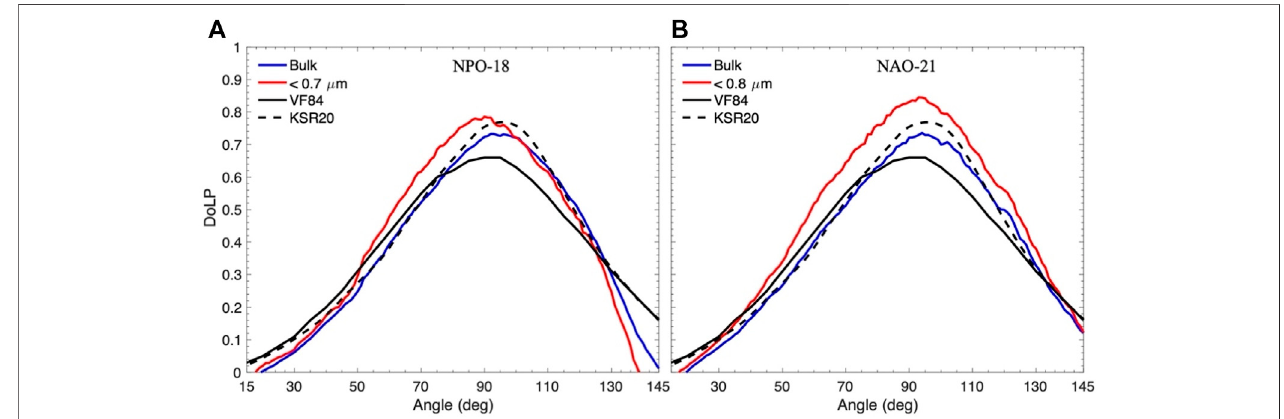
FIGURE7| Medianvaluesofdegreeoflinearpolarization(DoLP)measuredforthebulkandsubmicronparticlesinthe (A) NPO-18and (B) NAO-21sites.Theblack solidand dash linesaremeanDoLP measured byVossand Fry(1984) inthenorthernPaci fi candeasternAtlantic oceans(VF84) andKoestneretal.(2020) inthecoastal waters of San Diego (KSR20),